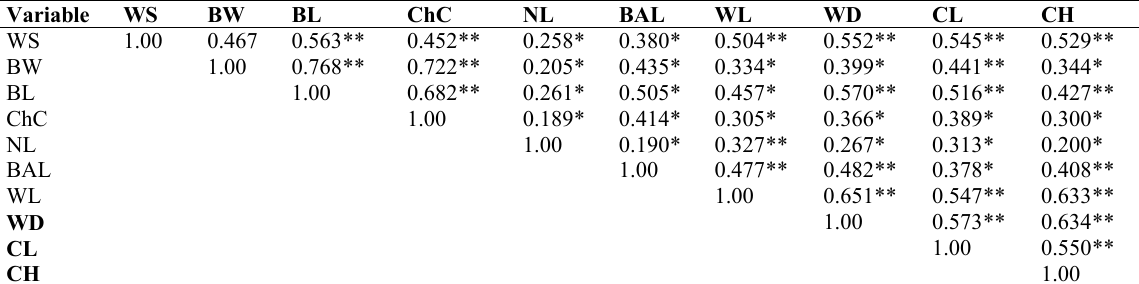
Table 4. Pearson correlation coefficient analysis for linear body measurements . Variable WS